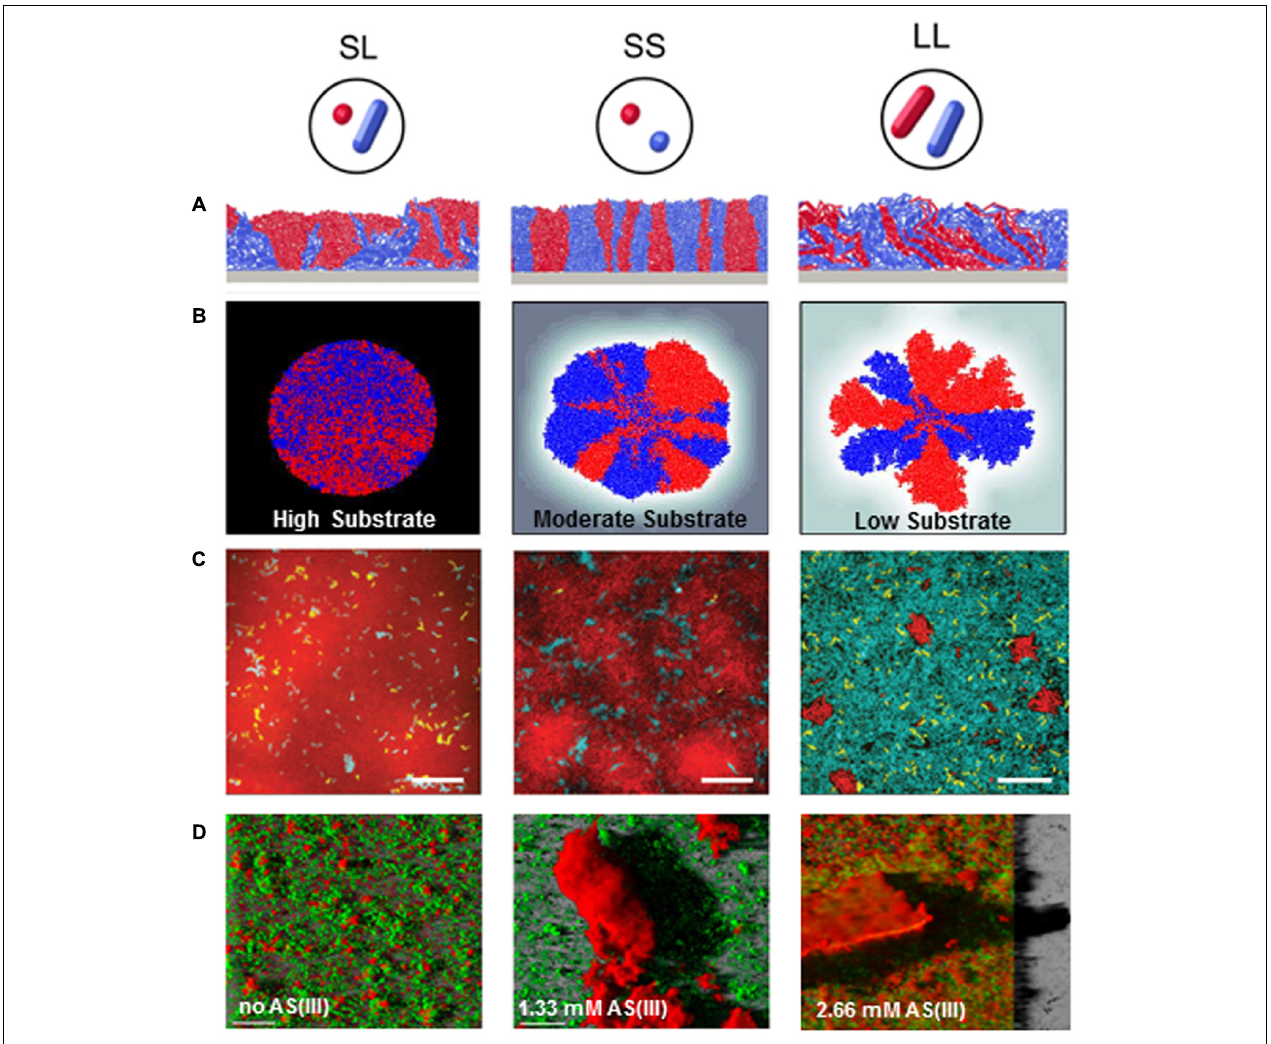
FIGURE 2 | Biofilm architectural modulations in response to environmental stimuli or depending on bacterial composition. (A) Impact of cell morphology on biofilm spatial organization. Images displayed 2D sections from simulations where biofilms exponentially grown from 1:1 mixtures of red- and blue-labeled strains form distinct 3D patterns depending on the coccal (S) or rod-like (L) morphology of the strain (Adapted from Smith et al., 2017). (B) Impact of substrate availability (High, moderate and low availability) on biofilm architecture and lineage segregation. Simulations were started with a 1:1 mixture of red and blue cells, where cell color served a neutral marker for lineage segregation. Substrate concentration decrease was associated to a higher spatial segregation of cell lineages (Adapted from Nadell et al., 2010). (C) Impact of disturbance frequency on Vibrio cholerae biofilm spatial organization and strain competition. Images are optical sections taken from the bottom cell layer of biofilms initiated with a 1:1:1 mixture of wild-type strain (teal): a mutant strain hyper-secreting biofilm matrix (red): a mutant strain that is unable to produce extracellular matrix (yellow) cells in microfluidic devices (scale bar: 20 µ m). Biofilms grew under continuous nutrient provision (left), or underwent disturbance events every 12 h (middle) or every 6 h (right). Each disturbance event consist in stopping the flow during 2 h to lead to nutrient limitation. Cells were then allowed to disperse to a new microfluidic chamber by pumping the dispersed cells from the initial chamber to the new chamber. After a 2 h-incubation, flow was resumed to pump fresh medium in the newly colonized chamber and enable biofilm growth (adapted from Yan et al., 2017). (D) Impact of toxic on EPS production and biofilm structure in Thiomonas sp. CB2. Images show three dimensional confocal reconstruction of 7 day-old biofilms cultivated in the absence, or in the presence of 1.33 and 2.67 mM Arsenic [As(III)]. Biofilms were stained using SYTO9 (cells, green) and ConA (exopolysaccharides, red) (Adapted from Marchal et al.,